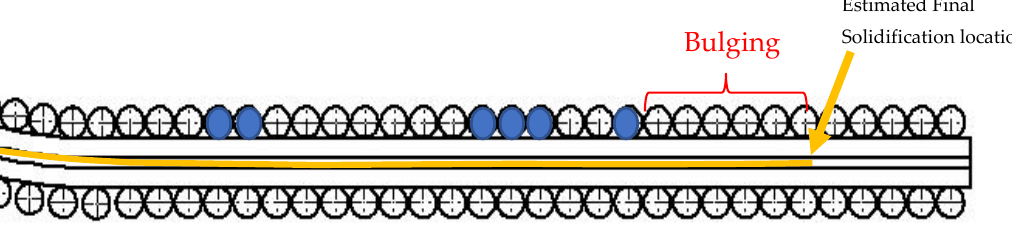
Figure 25. Liquid core position predicted by Burns Harbor caster model for heat 8.